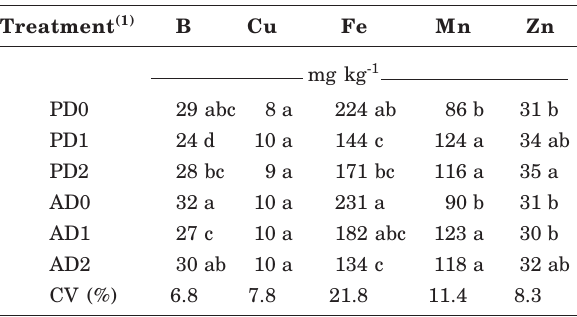
Values followed by same letter in columns, are not significantly different at p 0.05 according to LSD test. (1) PD0 = Pérola without NPK fertilization, PD1 = Pérola with 50 % of recommended NPK fertilization; Pérola PD2 = Pérola with 100 % of recommended NPK fertilization; AD0 = IAC Alvorada without NPK fertilization, AD1 = IAC Alvorada with 50 % of recommended NPK fertilization; AD2 = IAC Alvorada with 100 % of recommended NPK